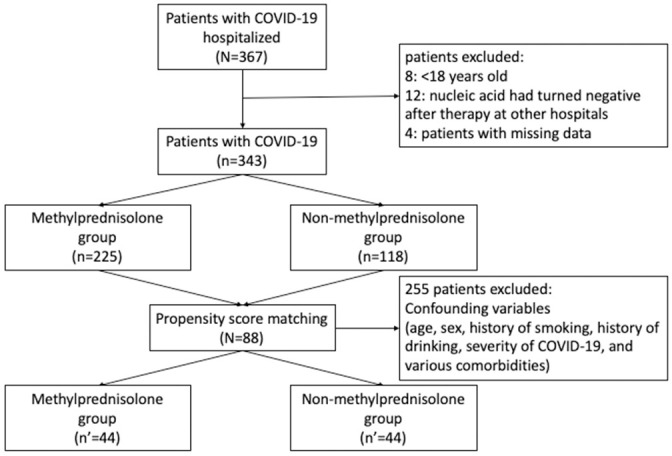
The flow chart of subject selection.